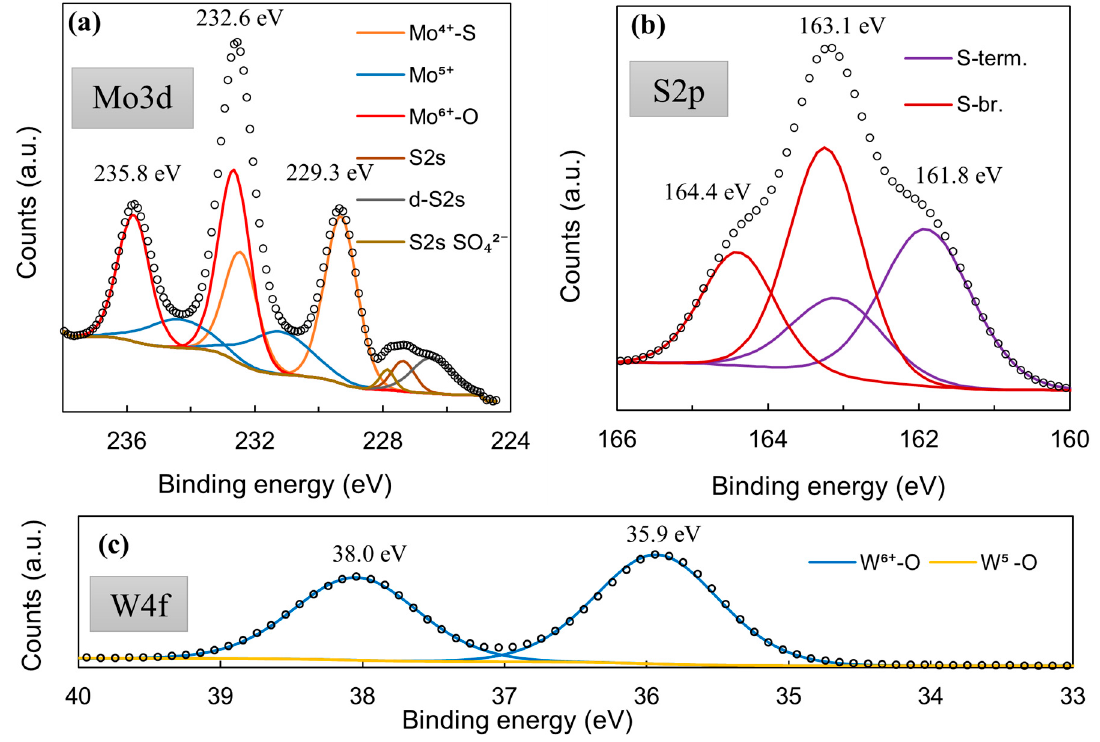
Figure 5. High-resolution XPS spectra of a 5-min-WO 3 /MoS x fi lm: Mo3d ( a ), S2p ( b ), W4f ( c ).